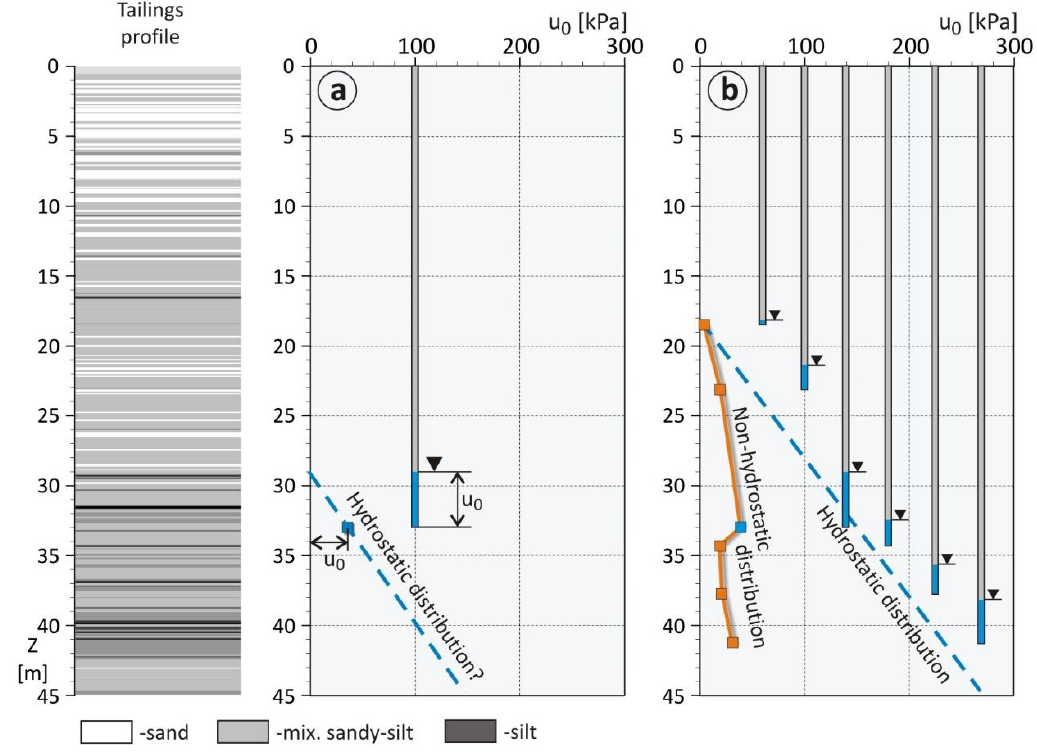
Figure 6. The comparison of the assessment of water conditions in sediments based on ( a ) single and ( b ) multiple piezometers readings.